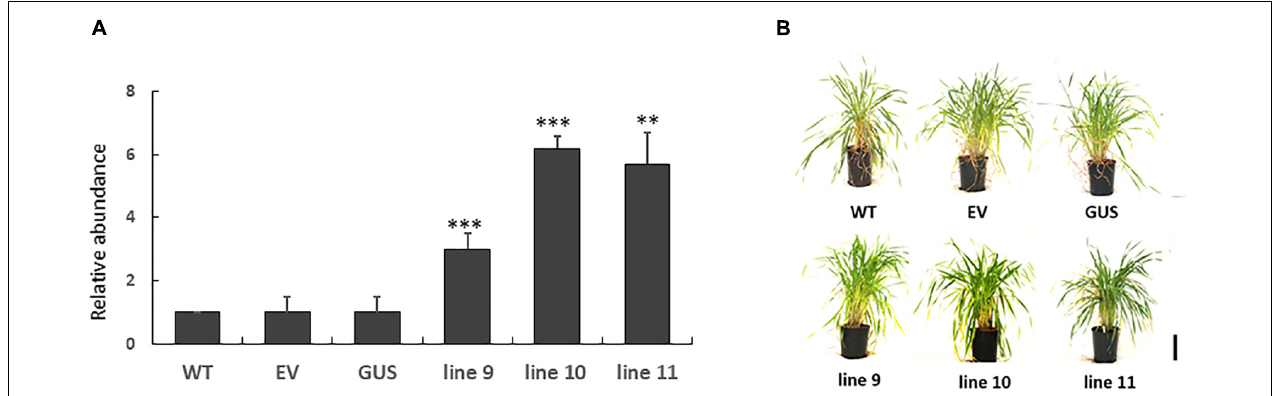
FIGURE 6 | The expression of Arabidopsis LEA5 in transgenic barley lines (9, 10, 11) relative to controls (WT, EV, GUS) and the growth phenotypes of these lines. The relative abundance of LEA5 in barley lines expressing the Arabidopsis LEA5 sequence (9, 10, 11), control lines expressing empty vector (EV) and beta-glucuronidase (GUS) and WT (A) . The shoot phenotypes of the lines at 4 weeks (B) . Two asterisks indicates significant differences at p < 0.001 and three asterisks indicates significance at p < 0.0001. TABLE 3 | Yield parameters in transgenic barley lines expressing LEA5 in comparison to the wild type (WT) and a control barley line expressing beta-glucuronidase (GUS). WT GUS Line 9 Line 10 Line 11 Number of fertile tillers 12 13 22** 25*** 19** Total seed yield (g) 4.37 4.51 8.09** 8.16** 6.57** Seed yield per fertile tiller (g) 0.36 0.38 0.67** 0.68** 0.55** Data are mean values ± SE (n = 10). Significantly differences according to the Students t-test are indicated by